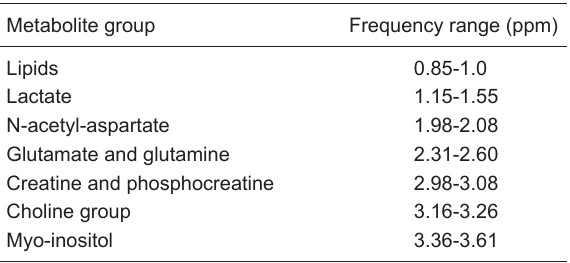
Table 2. Frequency ranges used in the AMARES quantification